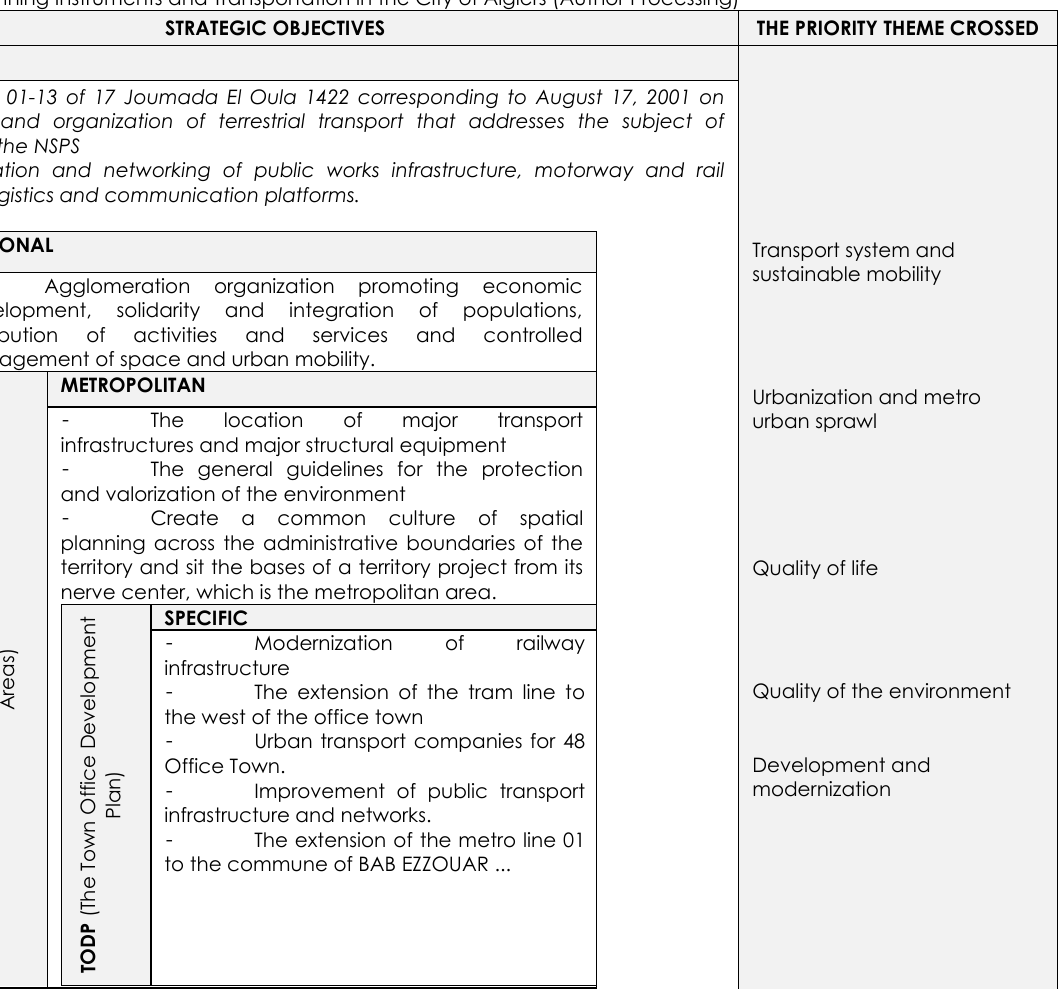
Table 6. Urban Planning Instruments and Transportation in the City of Algiers (Author Processing) STRATEGIC OBJECTIVES THE PRIORITY THEME